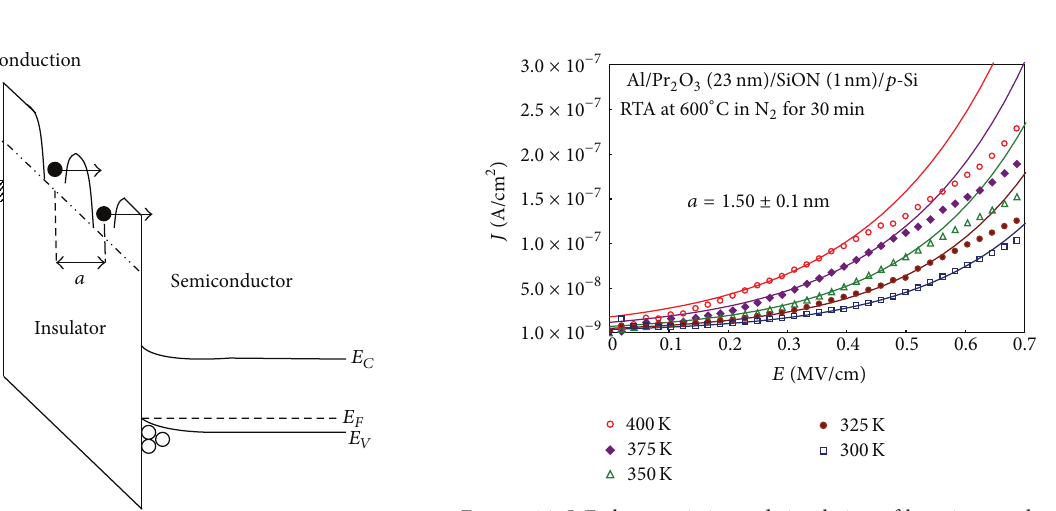
Figure 14: Characteristics of P-F emission at various temperatures. Inset graph presents Poole-Frenkel emission constrained by 𝑛 = 𝜀 1/2 𝑟 at high temperatures.